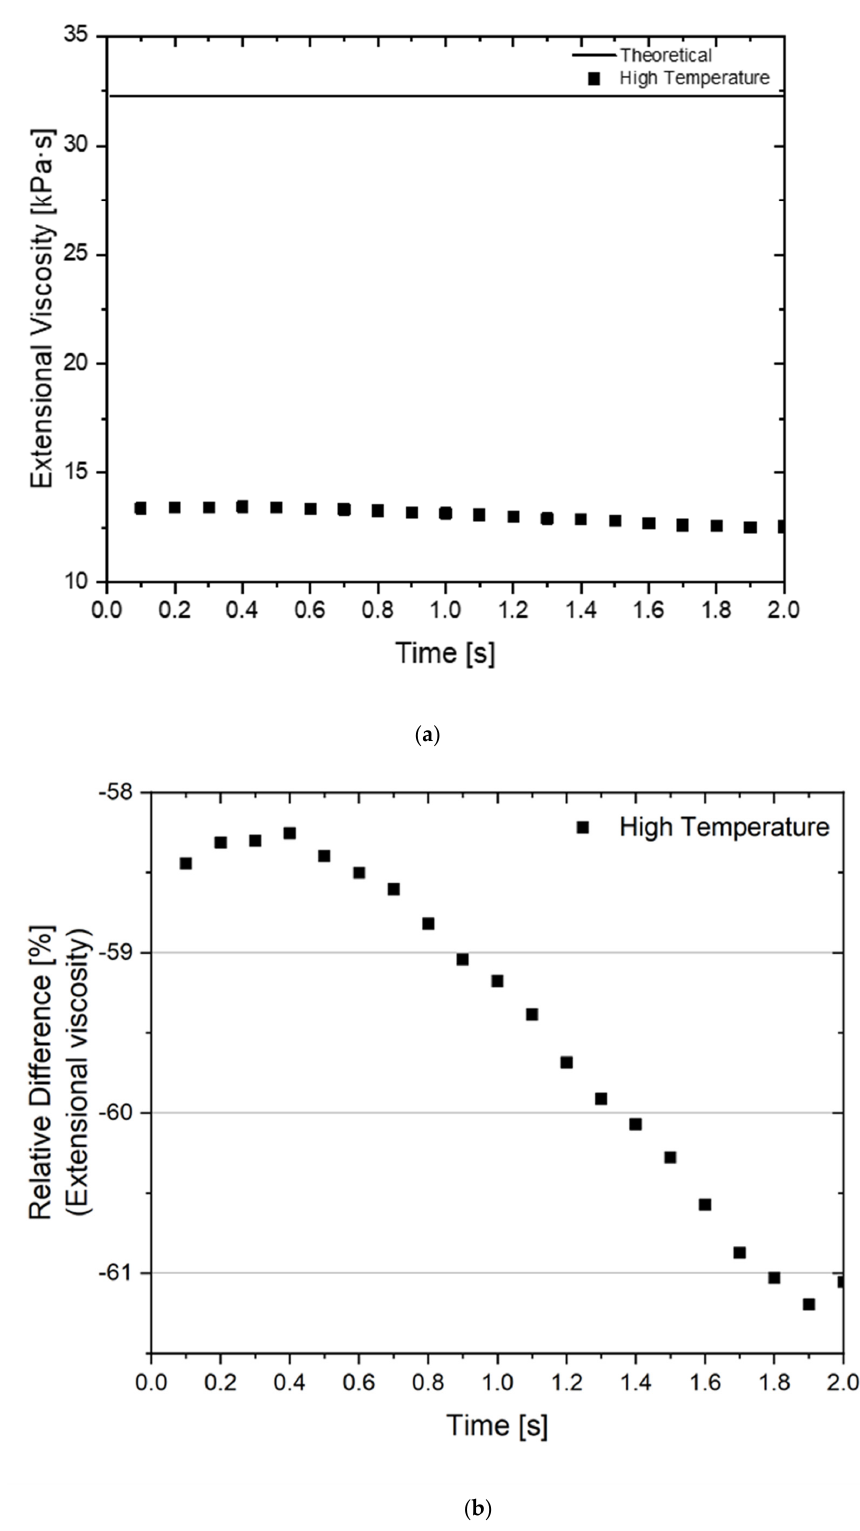
Figure 13. Results of the higher temperature case study: ( a ) extensional viscosity, ( b ) relative difference between theoretical and numerical extensional viscosities.